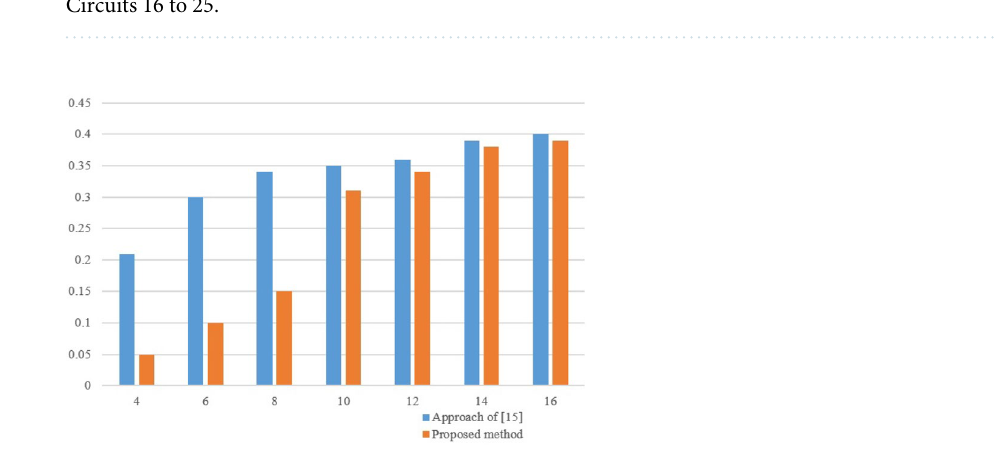
Figure 6. The proportion of the required teleportations over the total two-qubit gates when QFT circuit is distributed across 4,6,8,...16 quantum devices in comparison with 20 .